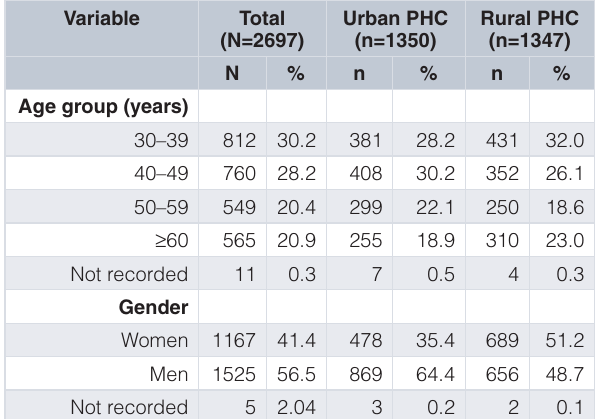
Table 2. Socio-demographic characteristics among persons aged ≥ 30 years seeking health care in the two selected primary health centres (PHCs) from March to May 2019 (N=2697).